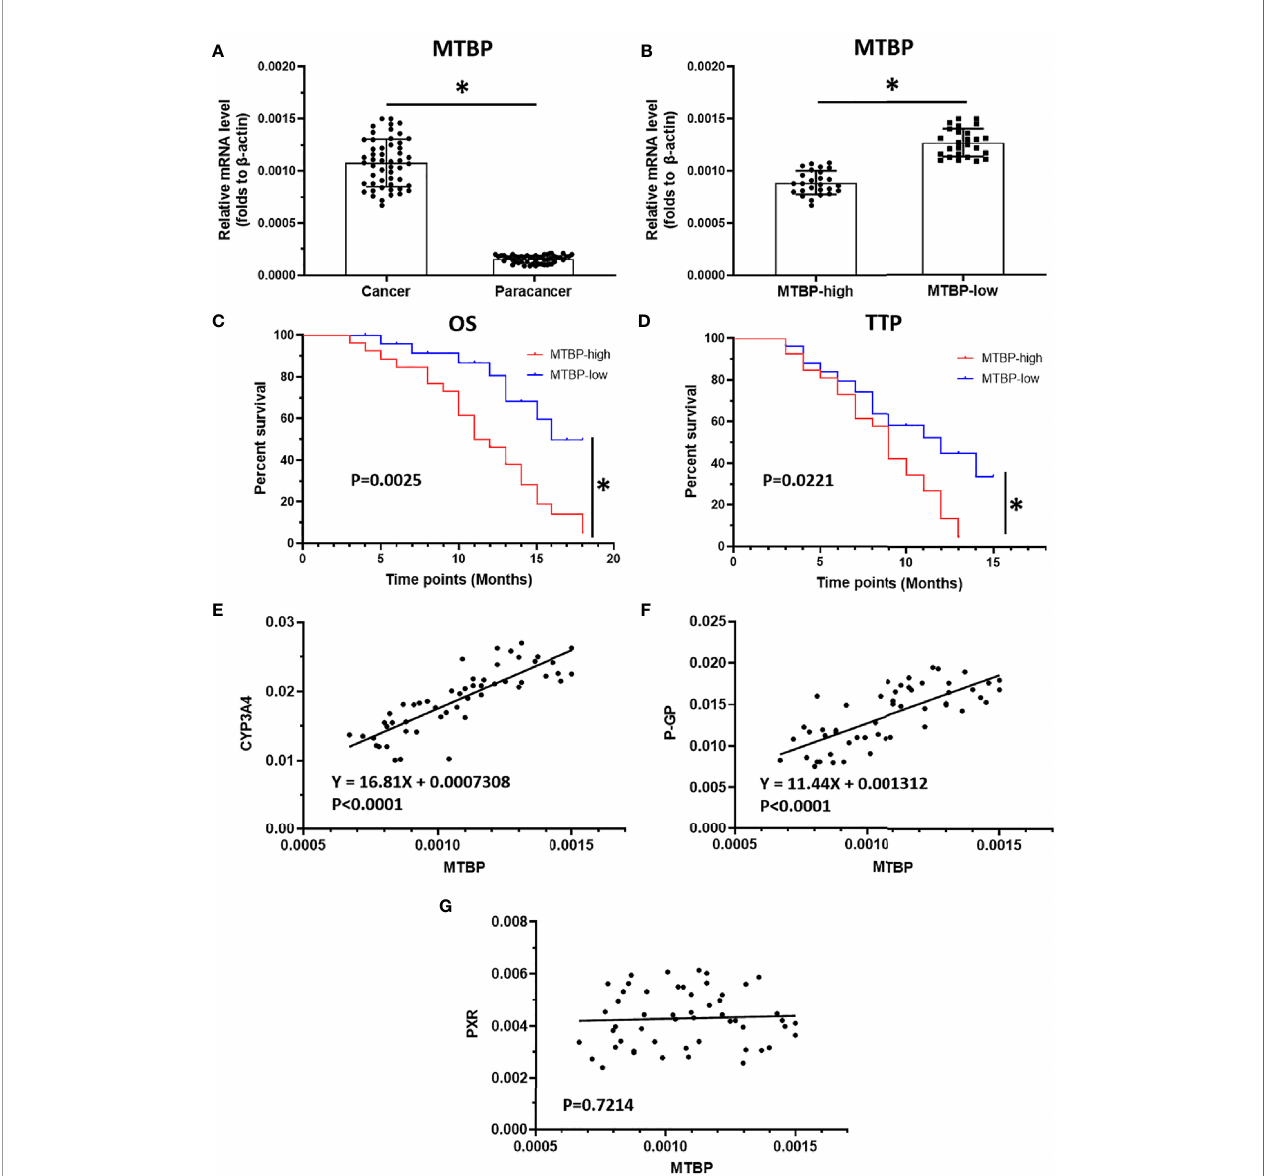
FIGURE 8 | The high level of MTBP is related to the poor prognosis of advanced HCC patients who received sorafenib treatment. (A) The mRNA level of MTBP in the HCC clinical specimens and the paired non-tumor specimens were examined by qPCR. (B) The patients with advanced HCC were divided into two groups (MTBP-high or MTBP-low) according to the median value of MTBP ’ s mRNA level. (C, D) The OS or TTP of MTBP-high or MTBP-low groups ’ patients are shown as survival curves. (E, F) The relationship between the expression of MTBP and the expression of PXR ’ s downstream genes CYP3A4 (E) and ABCB1 is represented (F) . (G) The co-relation between MTBP with PXR in HCC clinical specimens and was shown as scatter-plot images. *P <